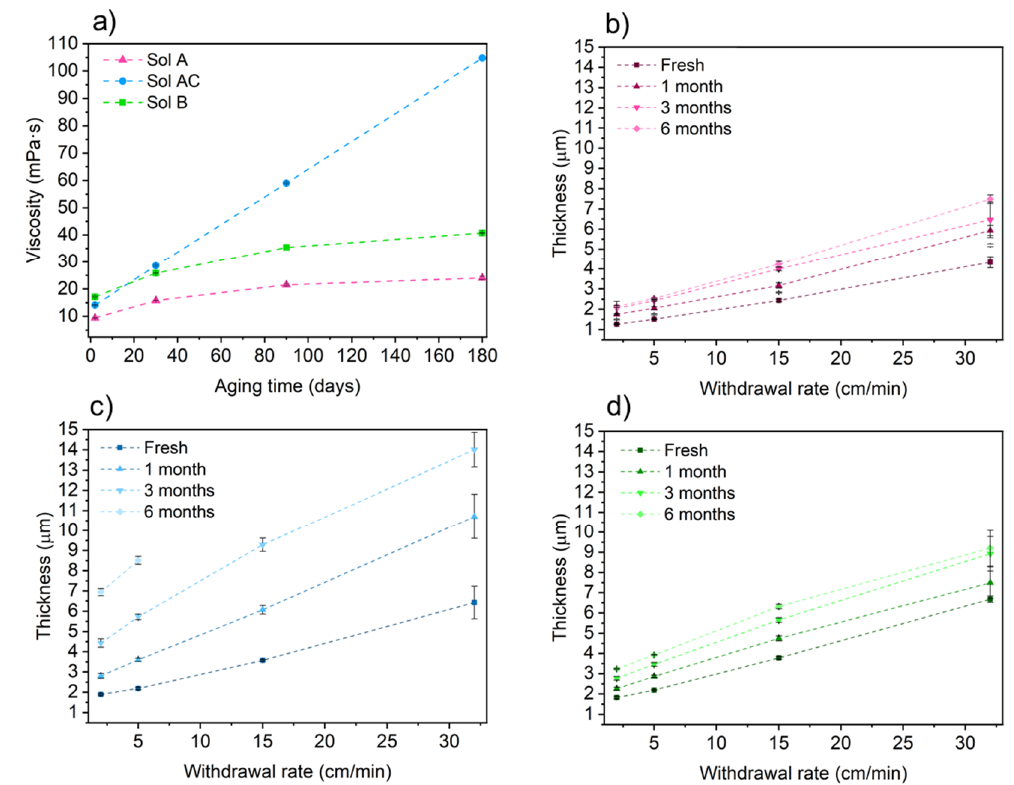
Figure 1. ( a ) Viscosity evolution of investigated sols and ( b – d ) thickness of coatings derived from ( b ) Sol A, ( c ) Sol AC and ( d ) Sol B at several withdrawal rates. (Viscosity ± 0.5 mPa·s).